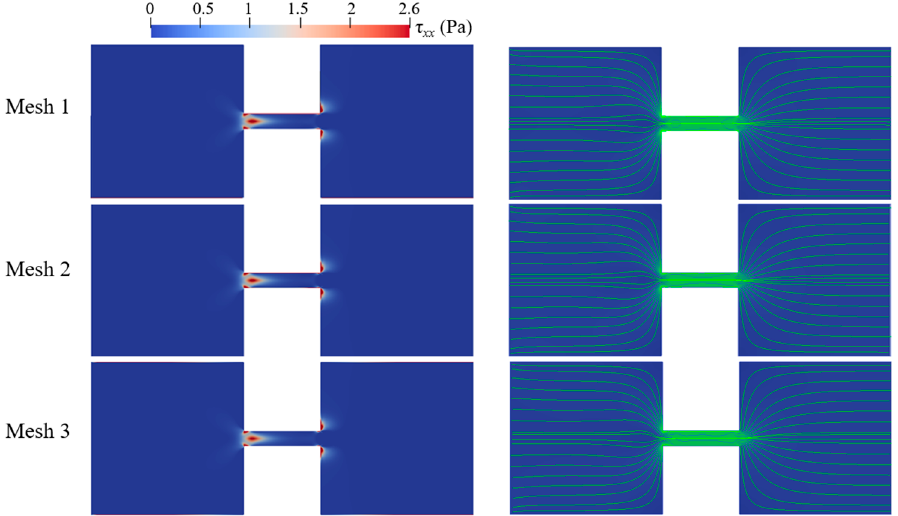
Figure A2. Spatial distribution of normal polymeric stress ( left ) and streamlines ( right ) for mesh 1 ( the top row ), mesh 2 ( the middle row ), and mesh 3 ( the bottom row ) at t = 1.78 s .